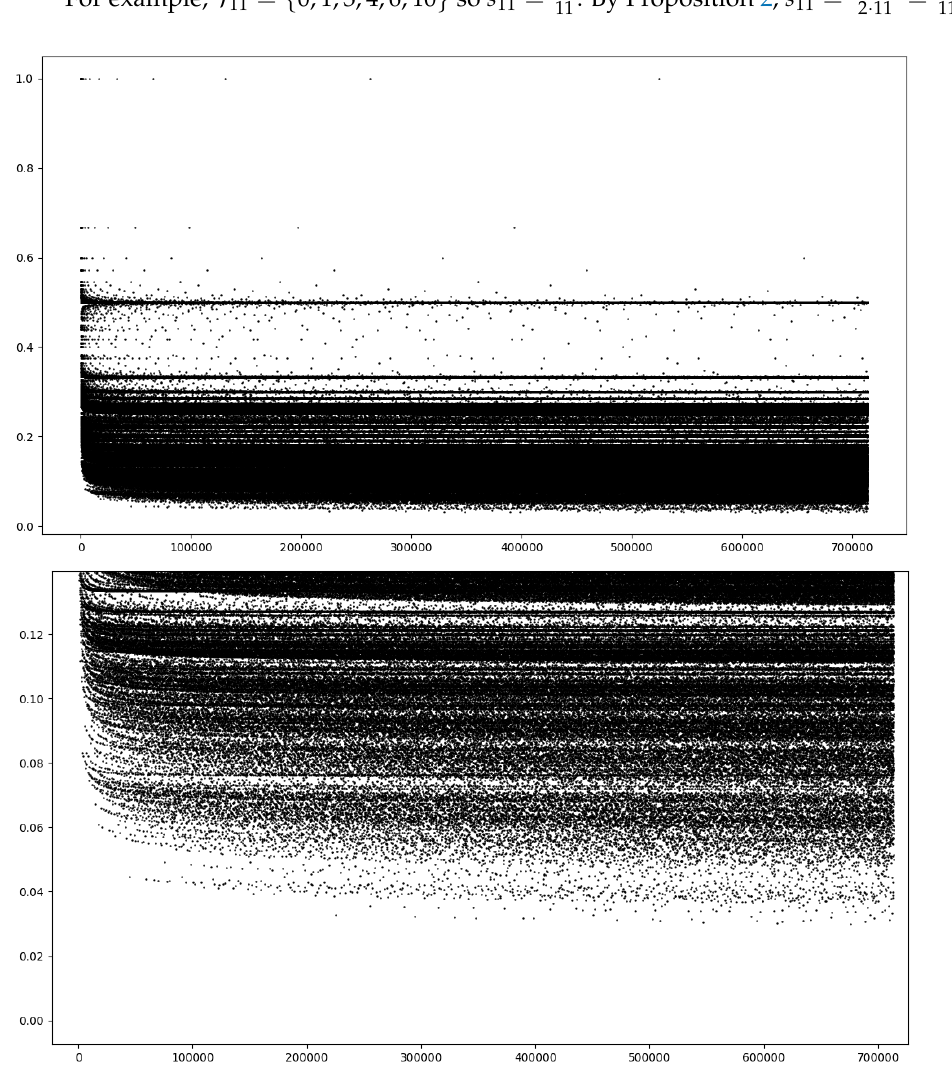
Figure 2. Saturation, s , (ordinate) versus m (abscissa) for the first 700,000 integers m . The top graph shows all the data, and the bottom graph shows a blow-up of the low saturation values. As will be seen to be typical throughout this work, there are striation patterns in the graph. The (rare) points that fall below the main region of values are highly composite